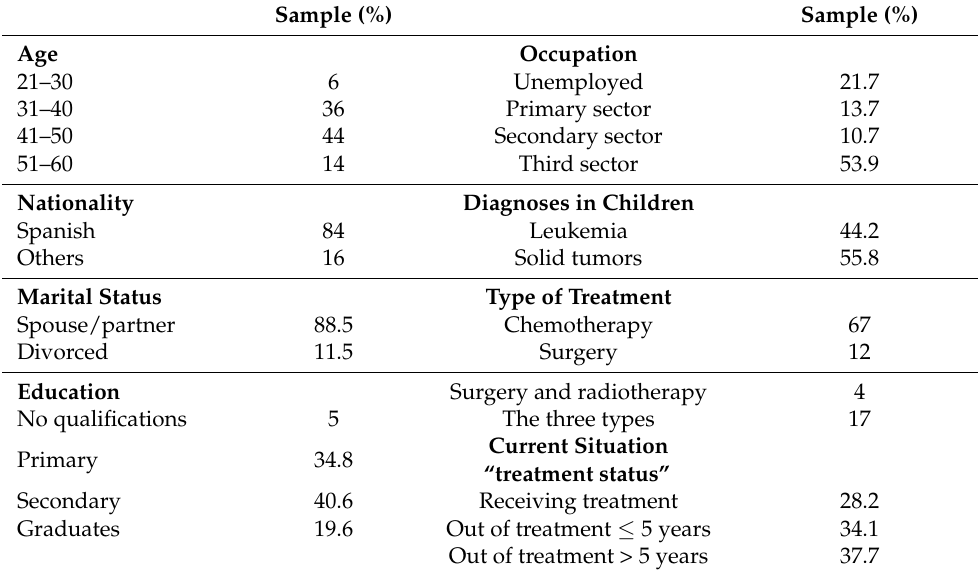
Table 1. Sociodemographic characteristics of parents and clinical conditions of their